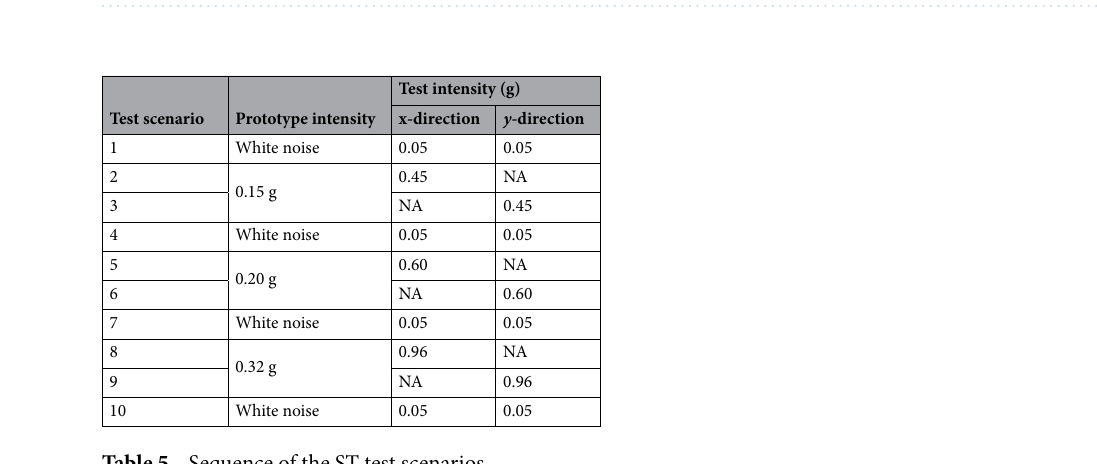
Figure 8. Response spectra at all considered hazard levels.